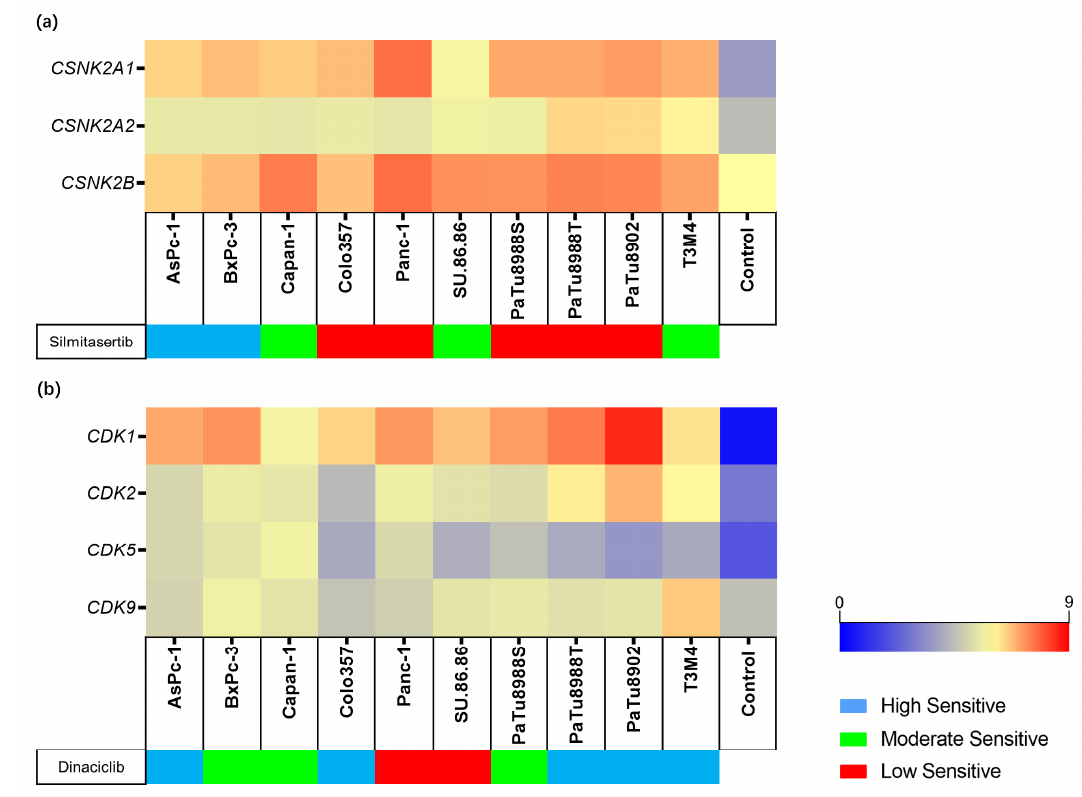
Figure 3. Gene expression levels of inhibitor target genes in the cell lines and control. The different sensitivity to silmitasertib ( a ) and dinaciclib ( b ) is indicated for each cell line. Gene expression levels are displayed as Log2